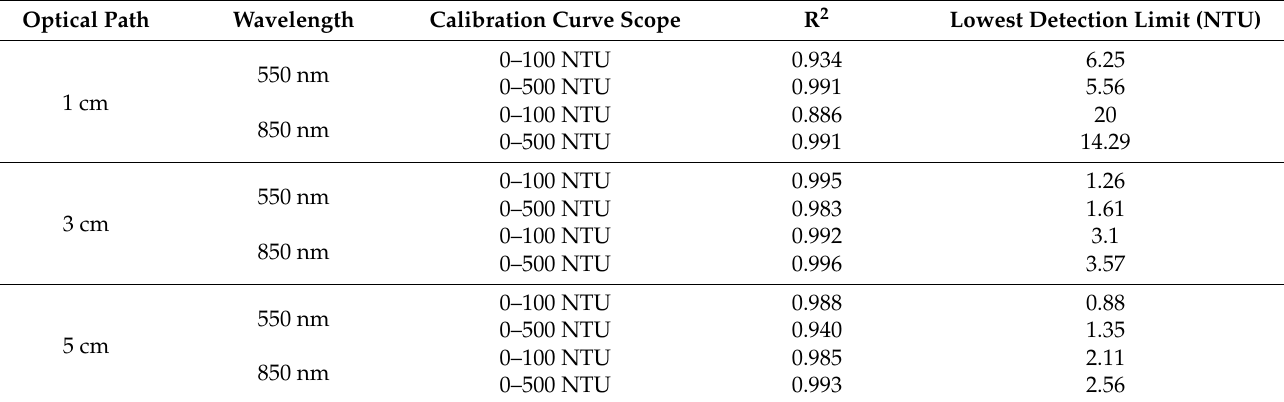
Figure 2. Absorbance of standard turbidity solutions in concentrations ranging 200–890 nm. Table 4. Various optical path molds’ calibration curves and lowest detection limits for wavelengths 550 nm and 850